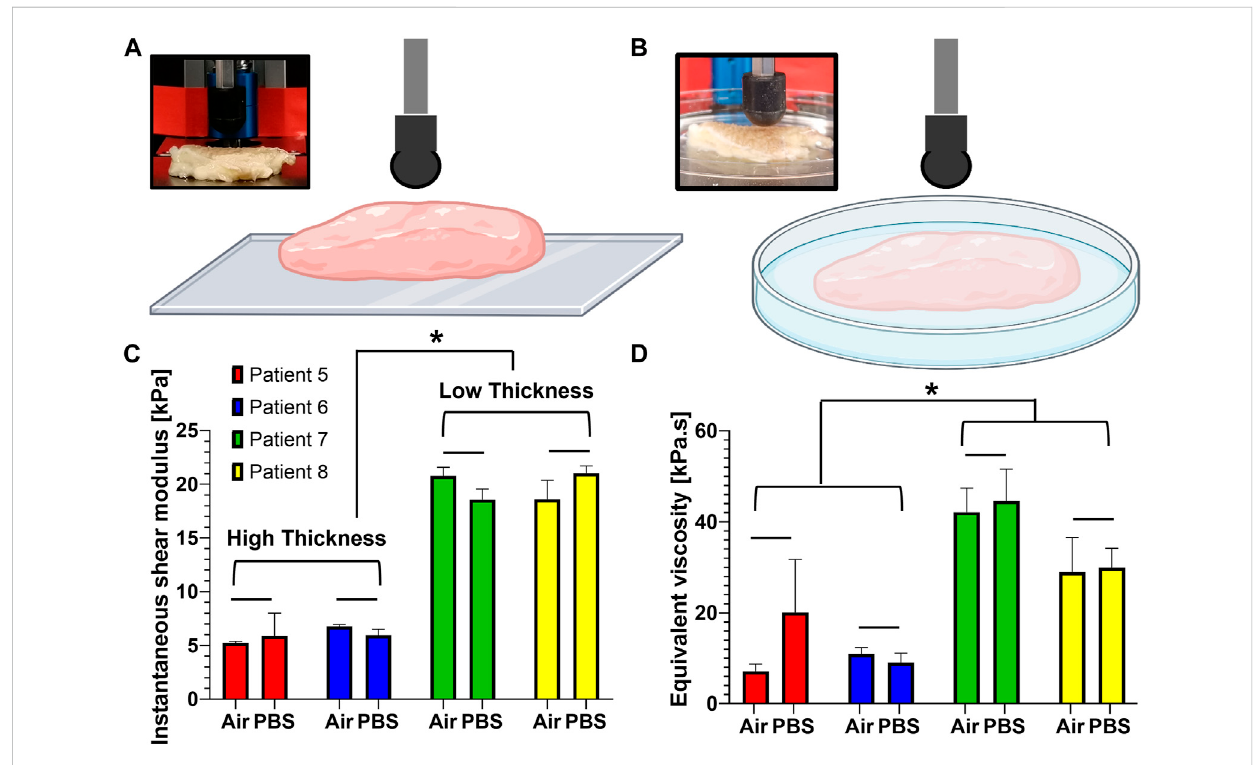
FIGURE 2 Comparison of the viscoelastic properties obtained from human melanoma tissues in air and PBS. (A, B) Schematic representation for the measurement of the viscoelastic properties between two submersion modes: air (A) and PBS (B) . (C) Instantaneous shear moduli obtained from the sampleswhensubmergedinairandPBS. (D) Equivalentviscositiesobtained fromthesampleswhensubmergedinairandPBS.Dataareshownasmean± standard error, and each test group was repeated at least three times. * p < 0.05; bar ( − ): not signi fi